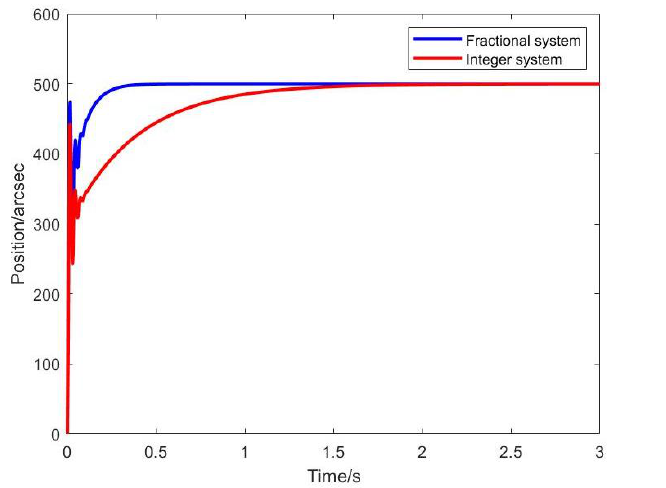
Figure 11. Step response of the fractional/integer-order system.